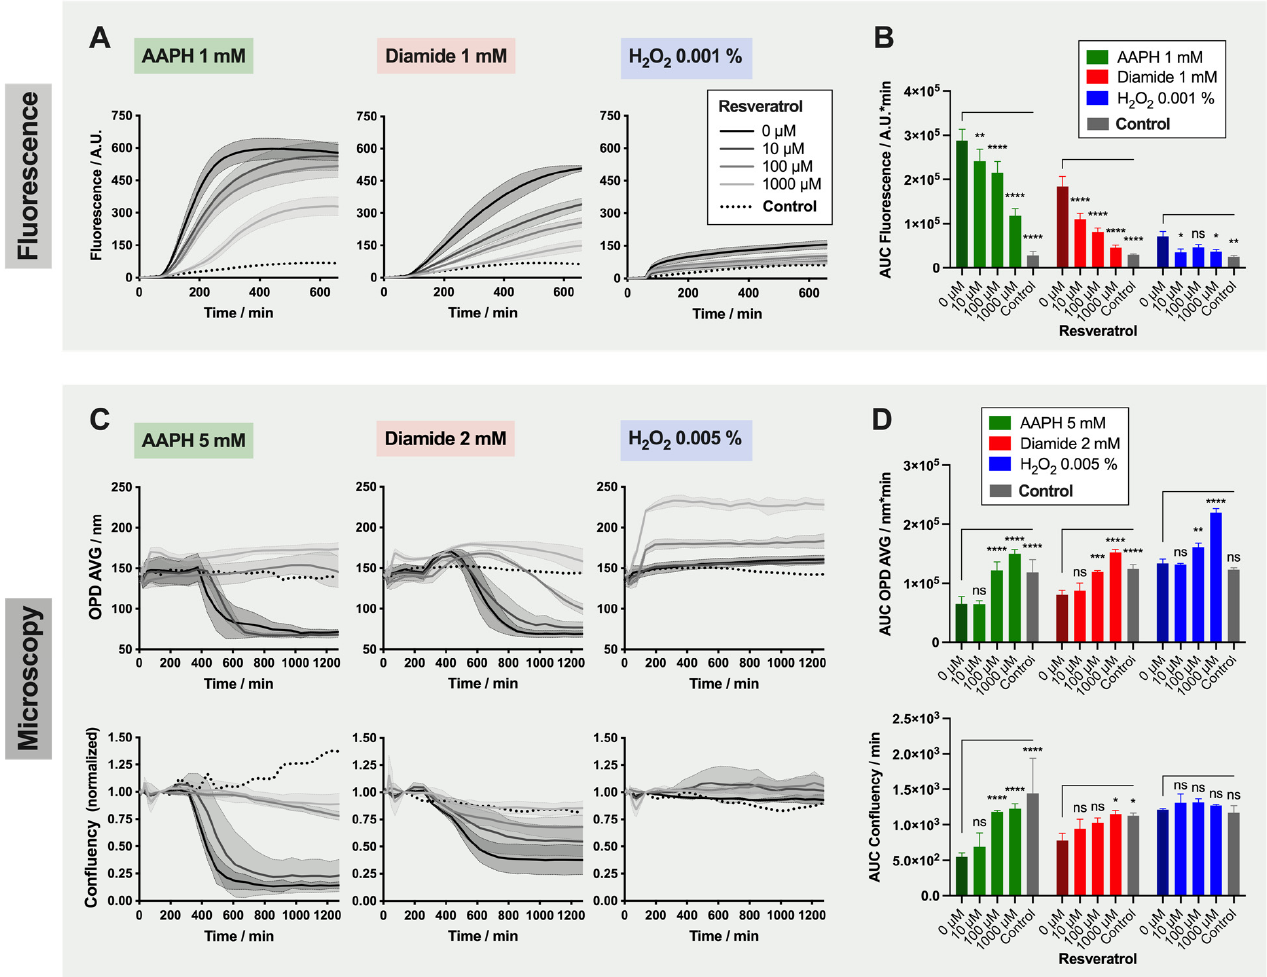
Figure 4. Assessment of the Protection Provided by Resveratrol against AAPH, Diamide and H 2 O 2 Oxidants. ( A ) Time-lapse analysis of fluorescence emission for red blood cells (RBCs) treated with 1 mM AAPH, 1 mM diamide or 0.001% H 2 O 2 , and 0, 10, 100 and 1000 µ M resveratrol. ( C ) Time-lapse analysis by digital holographic microscopy (DHM) of morphological changes triggered by 5 mM AAPH, 2 mM diamide or 0.005% H 2 O 2 , and 0, 10, 100 and 1000 µ M resveratrol. top: average of the optical path difference distribution (OPD AVG) parameter; bottom: normalized confluency ( B ) and ( D ) area under the curve (AUC) calculated from fluorescence and OPD AVG and confluency curves. Of note: control samples were neither treated with oxidants nor antioxidants. “No-antioxidant” control corresponding to the 0 µ M antioxidant samples are in darker color. For the AUC, two-way ANOVA was performed to compare the effect of resveratrol at different concentrations with the no-antioxidant condition; * p -value < 0.05, ** p -value < 0.01, *** p -value < 0.001, **** p -value < 0.0001, and “ns”